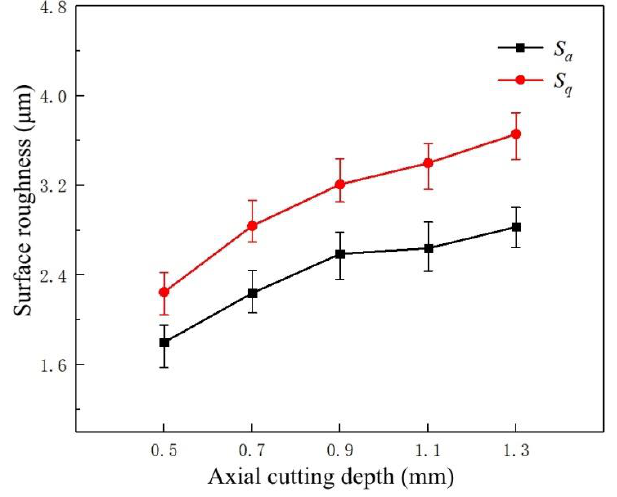
Figure 8. The variation trend of axial cutting depth on the surface roughness of the machined sur- faces.